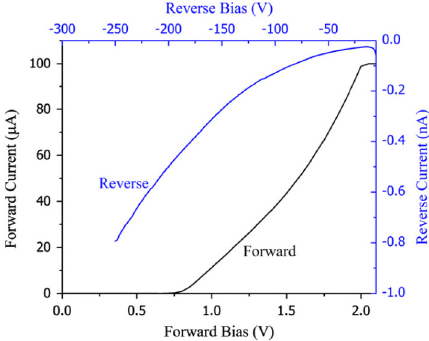
Figure 4. Forward and reverse I-V characteristics obtained for 50 µm n-type 4H-SiC epitaxial layer (n-S50) SBD with 3.8 mm diameter Ni contact.